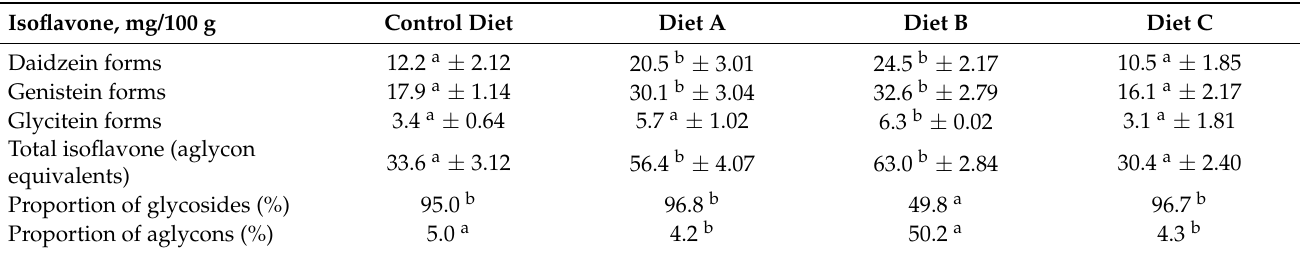
Table 2. Comparison of the isoflavone composition of the diets fed to aging White Leghorn hens (values represent the mean ± SD of duplicate